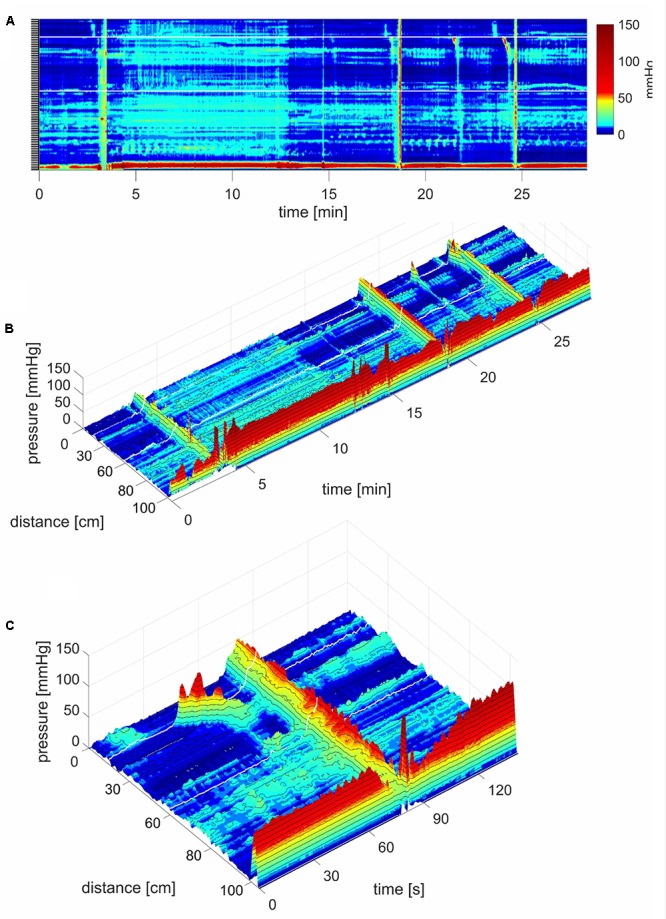
Simultaneous Pressure Waves in response to a meal. (A) SPWs that span the entire colon (102 cm). The lighter area, between ∼4 and 12 min, is the time period where the subject sits up causing an increase in intraluminal pressure, and takes in the meal. In this subject, a meal did not induce HAPWs but relatively high amplitude SPWs associated with liquid expulsion. An SPW appeared just before (anticipating the meal) and two following the meal. Anal sphincter relaxations were part of the SPW activity and the SPWs were consistently preceded by relatively low amplitude proximal propagating pressure waves. In addition, a lot of segmenting activity occurred. No pressure waves appeared in the time period between the end of balloon distention and the start of meal intake which was 20 min, except for the one just 1 min before meal intake. All three SPWs were associated with liquid outflow. (B) A 3D rendition of (A). (C) 3D image of an SPW.